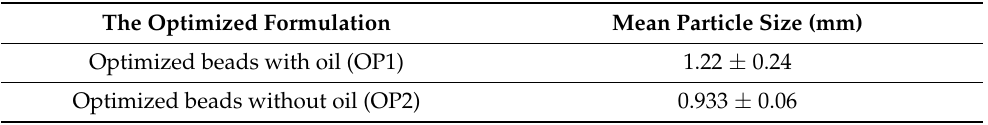
Table 5. Mean particle size of optimized formulation (OP1 and